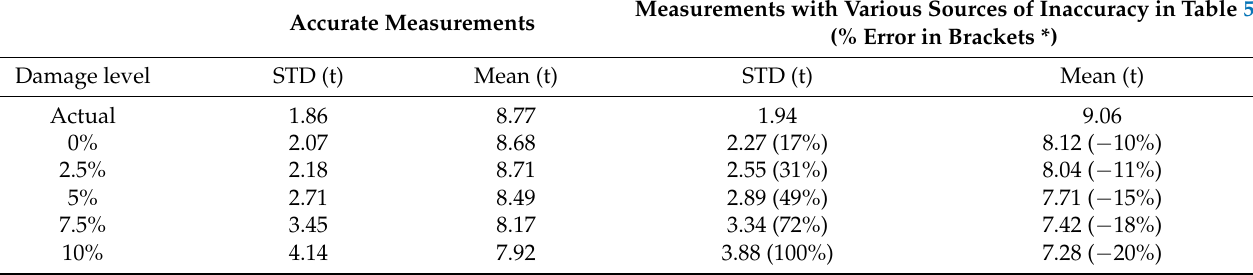
Table 4. Inferred GVW statistics for different damage